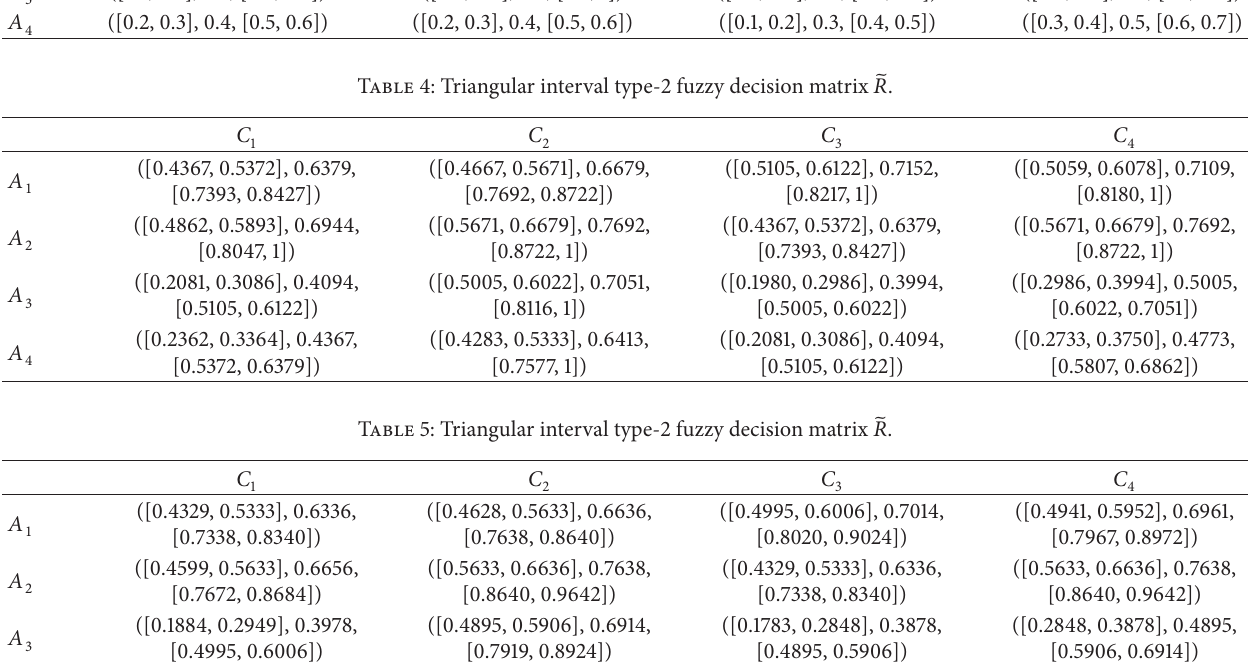
Table 3: Triangular interval type-2 fuzzy decision matrix